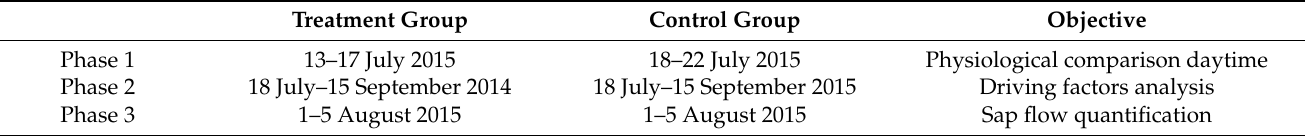
Table 2. Experimental design during the observation